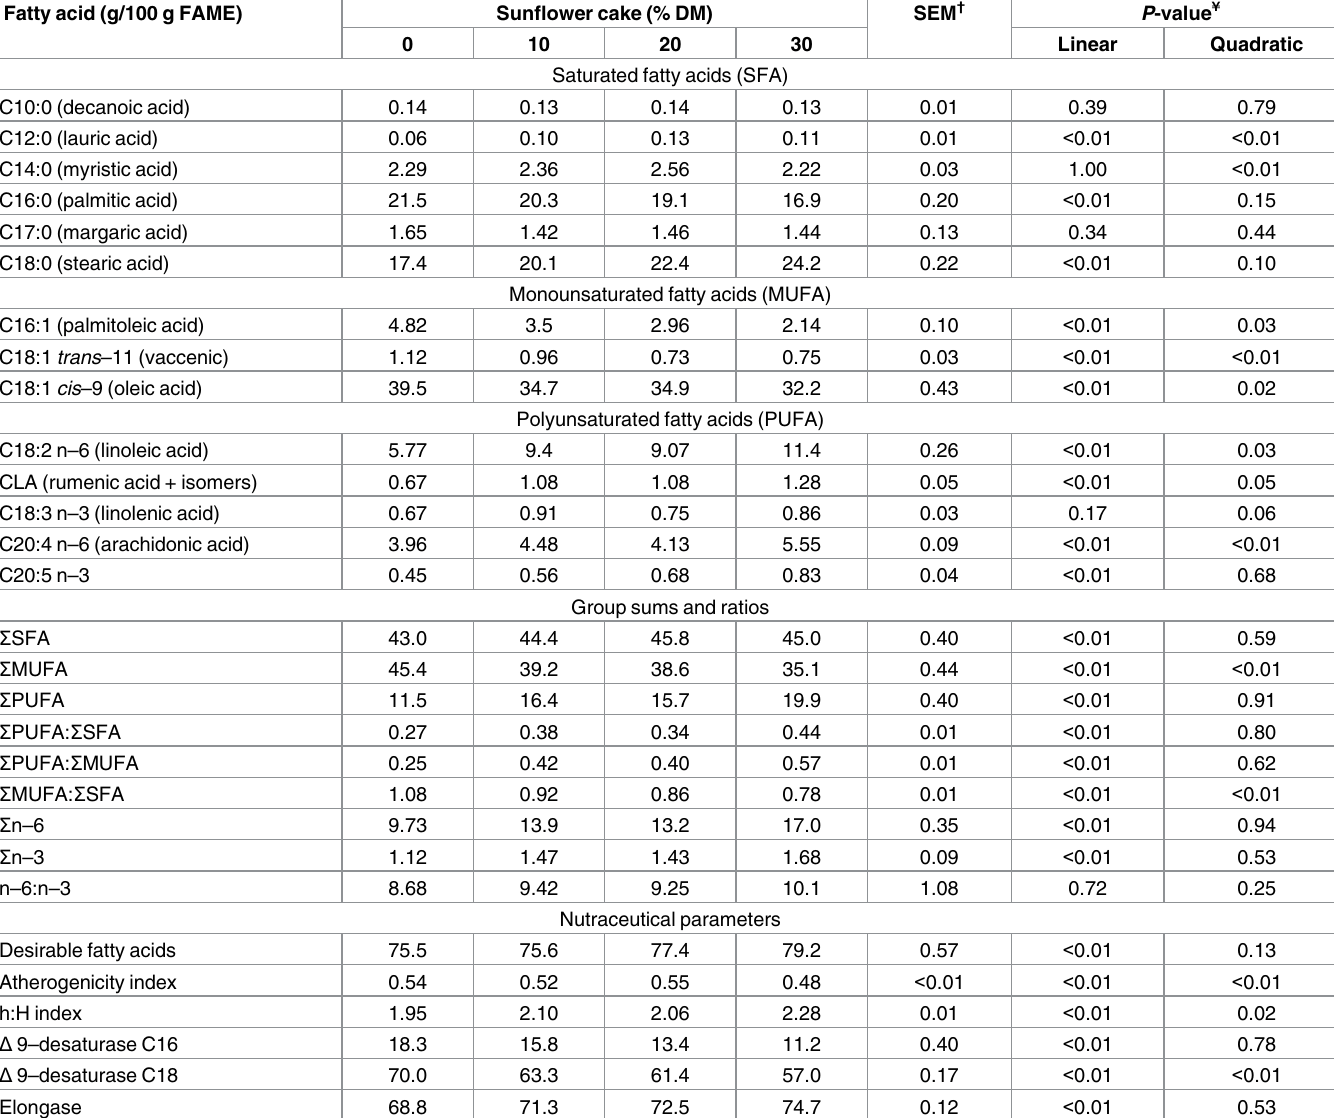
Table 4. Fatty acid composition (g/100 g FAME) in the longissimus lumborum muscle of Santa Ines lambs fed sunflower cake. Fatty acid (g/100 g FAME) Sunflower cake (%